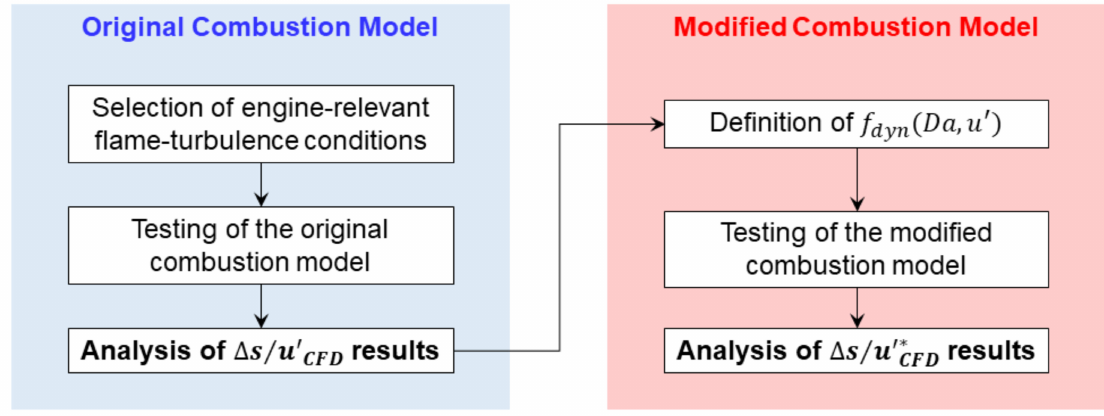
Figure 5. Methodology flowchart for the improvement of the simulated turbulent flame speed s T